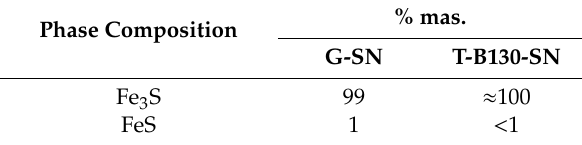
Table 4. Phase composition in the SL of Vancron 40 tool steel after: G-SN and T-B130-SN.